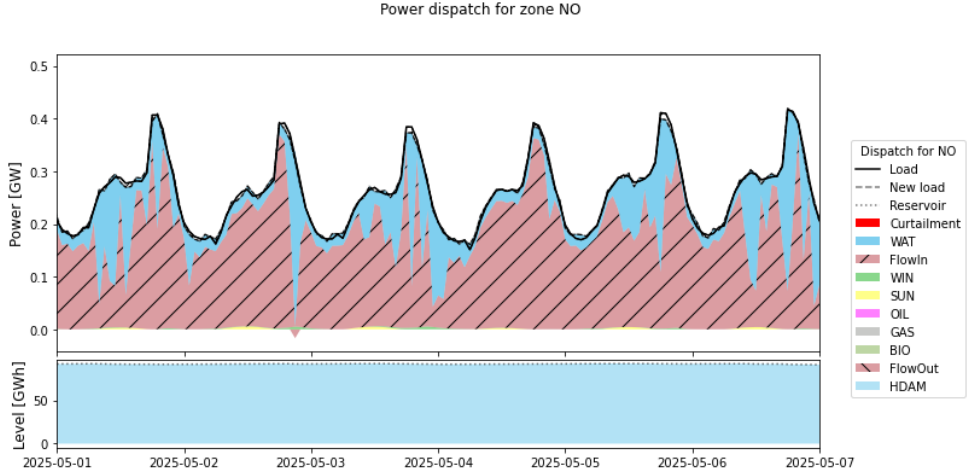
Figure 18. Low0Penetration Scenario 1(H)—Central zone (1–7 May 2025).